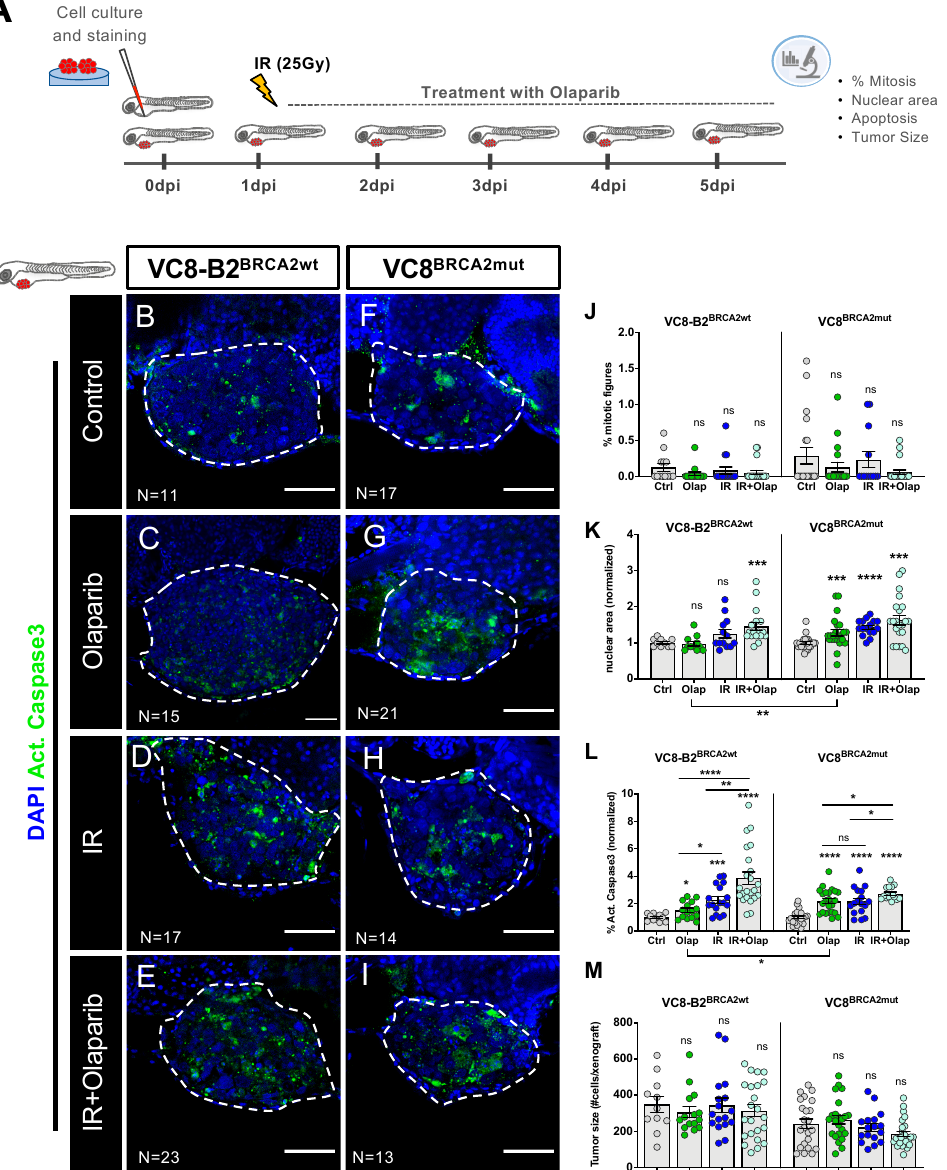
Figure 2. VC8 and VC8-B2 zebrafish xenografts show di ff erent sensitivities to treatment with olaparib and IR. VC8-B2 BRCA2wt and VC8 BRCA2mut cell lines were fluorescently labeled with CM-DiI (not shown) and injected into the perivitelline space (PVS) of 2dpf zebrafish embryos. At 24 h post-injection (24 hpi), zebrafish xenografts were screened and randomly distributed into the di ff erent experimental conditions: control, olaparib, IR, IR + olaparib. Xenografts were treated for 4 consecutive days and fixed at 5dpi ( A ). Zebrafish xenografts were sacrificed and fixed at 5dpi and prepared for confocal microscopy by immunolabeling for activated caspase 3 (marker for cellular death, in green) and nuclei staining with DAPI (in blue) ( B – I ). Mitotic index ( J ), nuclear area size ( K ), cell death-activated caspase 3 ( L ) and average tumor size (number of human DAPI cells) ( M ) were analyzed by confocal microscopy and quantified. The % of activated caspase 3 cells was normalized to respective controls to compare between di ff erent xenografts in di ff erent conditions. All images are anterior to the left, posterior to right, dorsal up, and ventral down (as depicted in the scheme on top left). The dashed line delineates the tumor area. Scale bar: 50 µ m. Results are from three independent experiments and expressed as mean ± standard error of the mean (SEM), each dot represents one xenograft. The total number of xenografts analyzed is indicated in the images. Statistical results: ns > 0.05, * p ≤ 0.05, ** p ≤ 0.01, *** p ≤ 0.001, **** p ≤